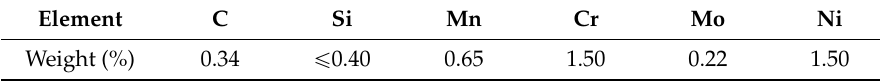
Table 1. Nominal chemical composition of DIN